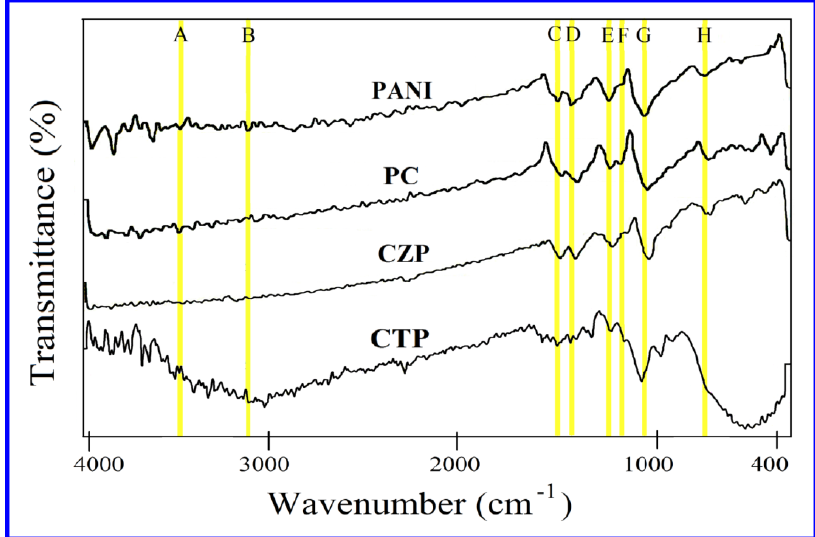
Figure 1. FTIR spectra of PANI. PC, CZP and CTP nanocomposites.